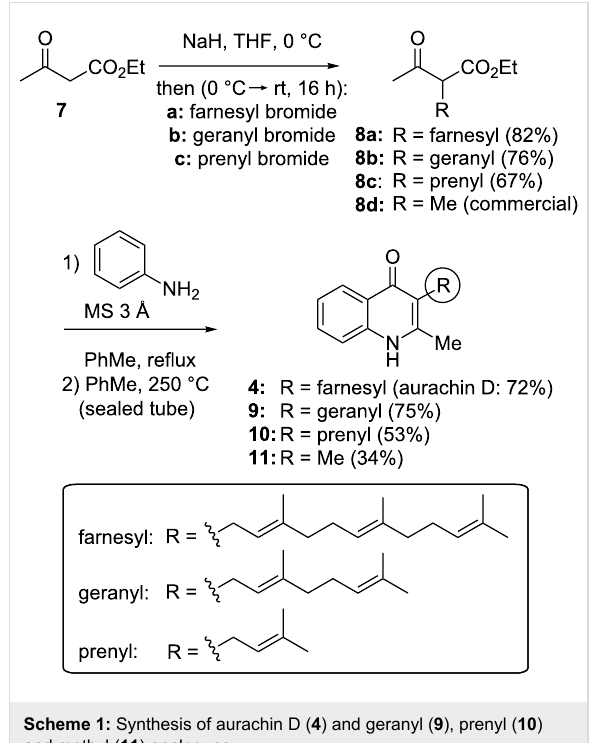
Scheme 1: Synthesis of aurachin D ( 4 ) and geranyl ( 9 ), prenyl ( 10 ) and methyl ( 11 ) analogues.